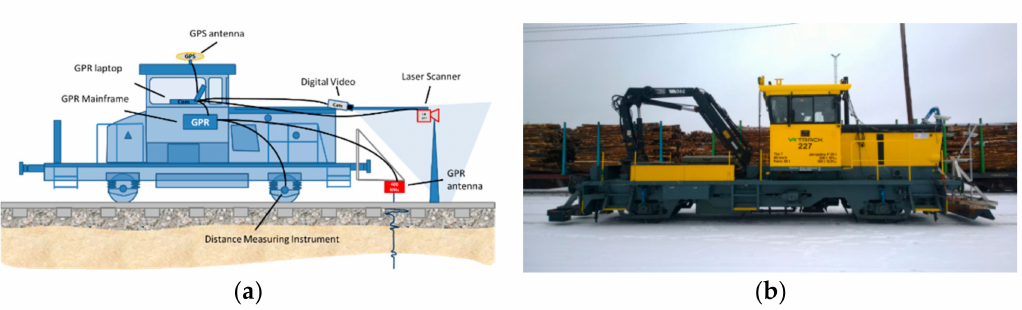
Figure 3. Railway engine with GPR system: ( a ) schematic diagram; ( b )